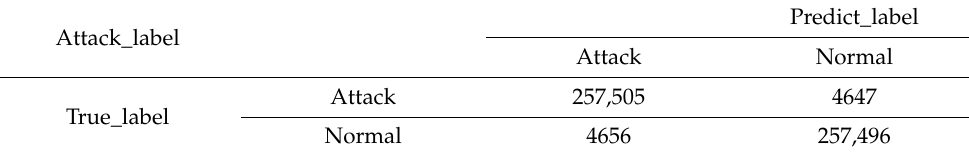
Table 8. Confusion matrix of KDD99 evaluating